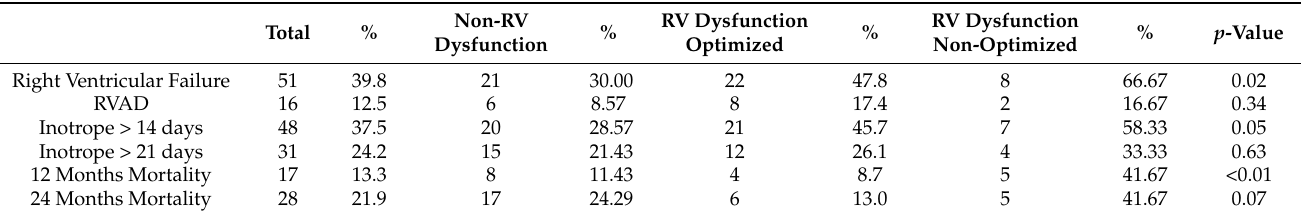
Table 3. Right Ventricle outcomes after LVAD